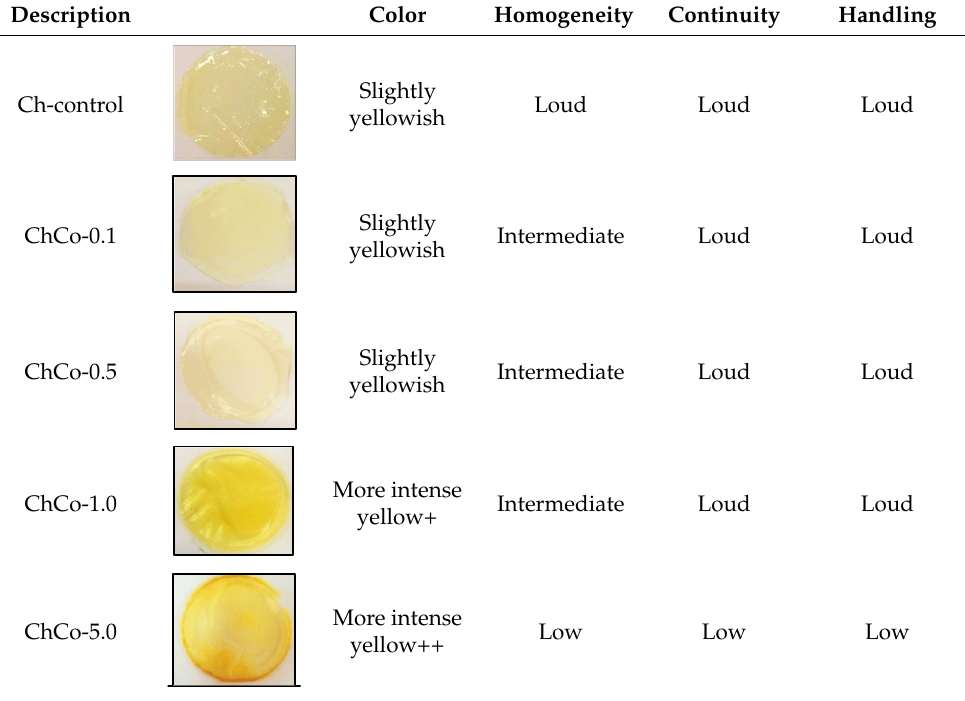
Table 2. Macroscopic characteristics of membranes.